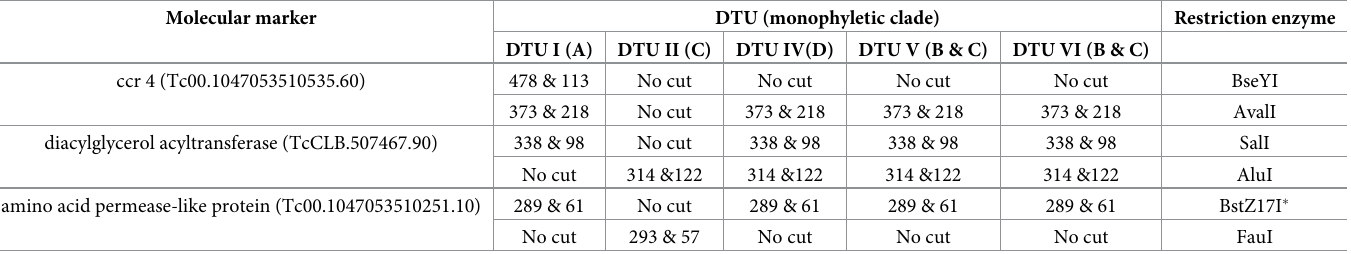
Numbers in cells represent the digestion fragment sizes in base pairs of DNA. “No cut” means the enzyme should not cause a digestion of the original PCR amplicon; therefore, the original PCR amplicon size (see Table 1) should be observed. � The enzyme AccI can be used in replacement of BstZ17I; however, AccI is more ambiguous with respect to the target site. Thus, the use of BstZ17I is recommended. TcIII is not included since no genome or DNA was available in our lab at the time of the study. Monophyletic clade A represents DTU I strains, B represents strains classified as DTU II, V & VI (since DTU V & VI are hybrids of DTUII and DTUIII ancestors), C represents strains of DTU III, V & VI, and monophyletic clade D represents strains classified as DTU